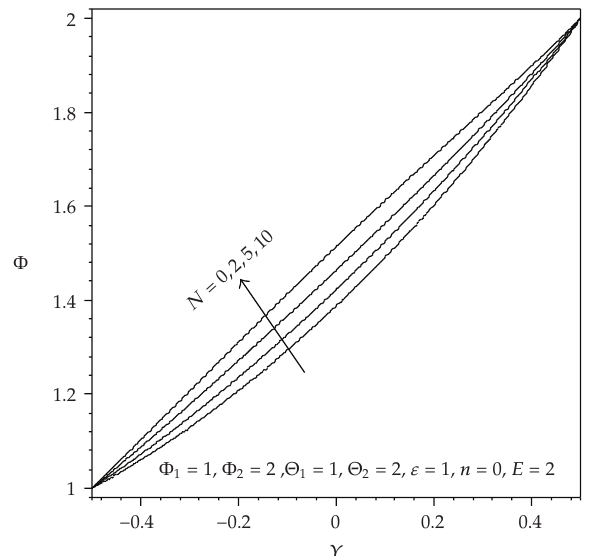
Figure 5: Concentration profiles as a function of Y for variations in the radiation parameter, N